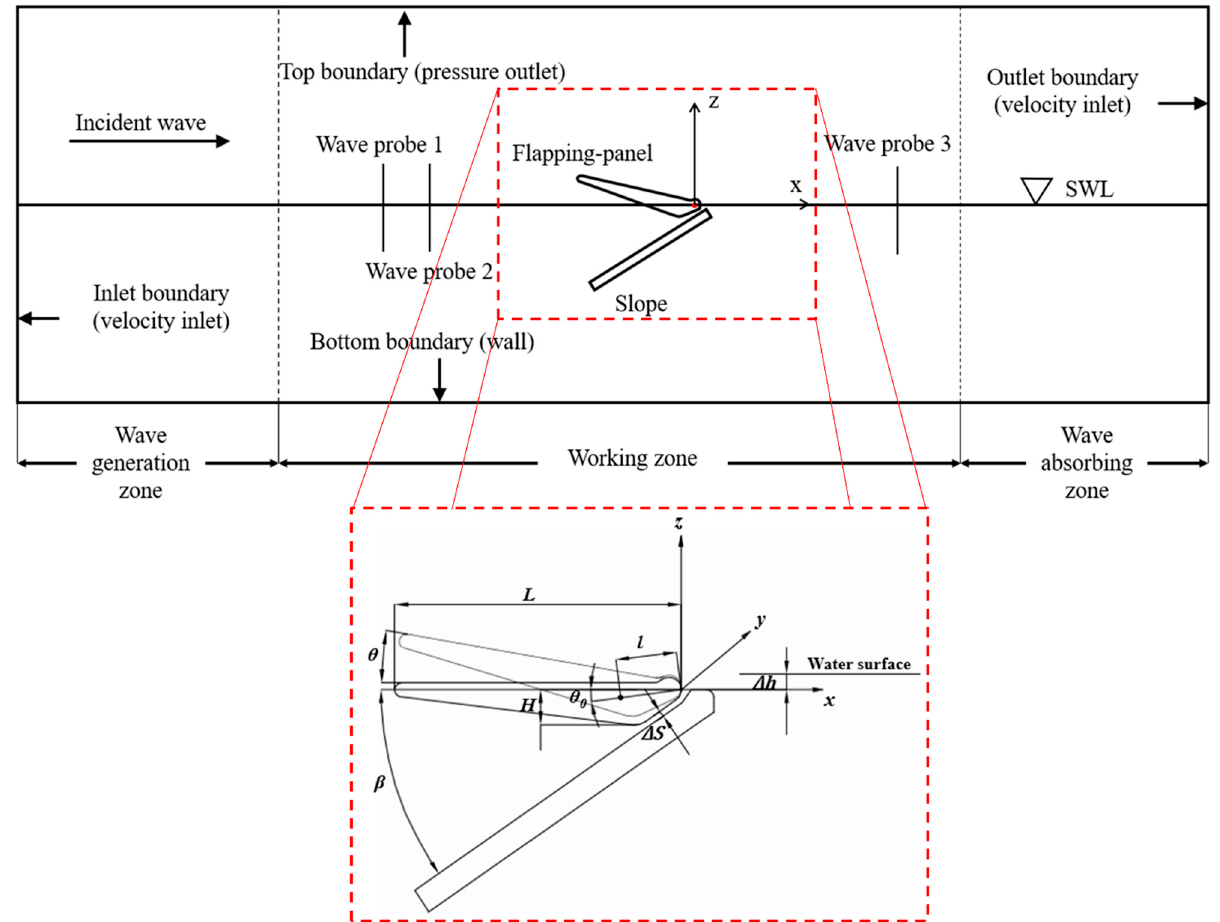
Figure 1. Schematic diagram of floating flapping-panel WEC.